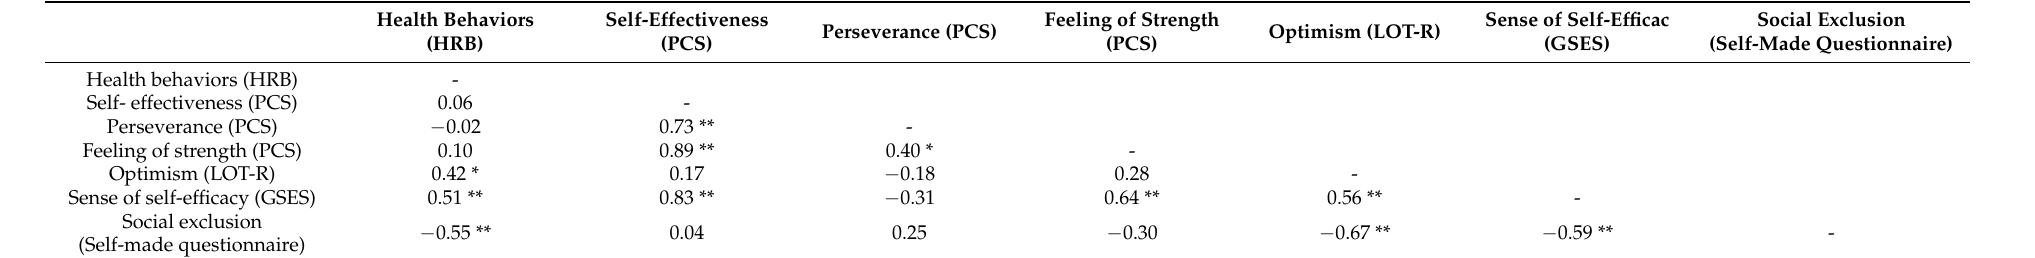
Table 3. Correlations between the studied variables in May